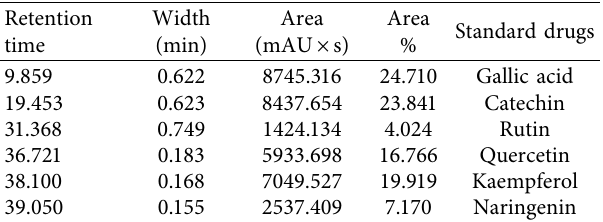
Table 3: Retention time of component compounds of a mixture of standard flavonoids.